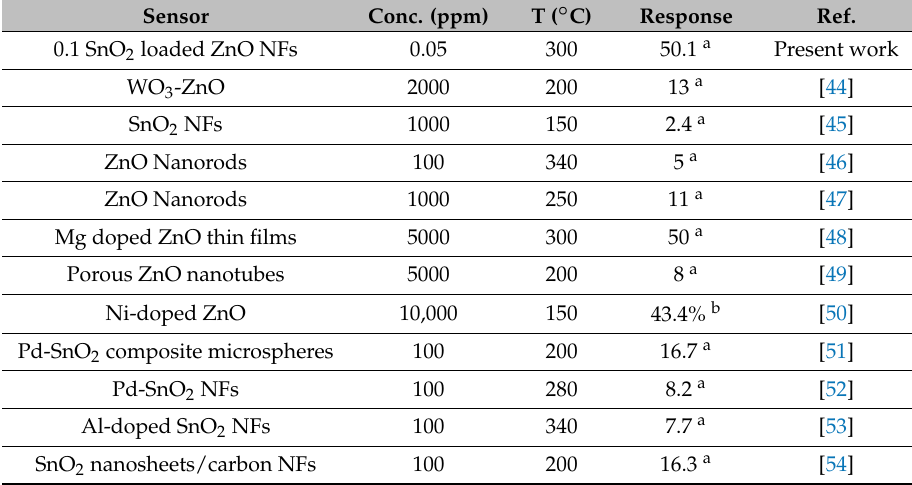
Table 1. Comparison between hydrogen gas sensing properties of the 0.1 SnO 2 -loaded ZnO NFs gas sensor with other ZnO-based or SnO 2 -based gas sensors reported in the literature. Sensor Conc.